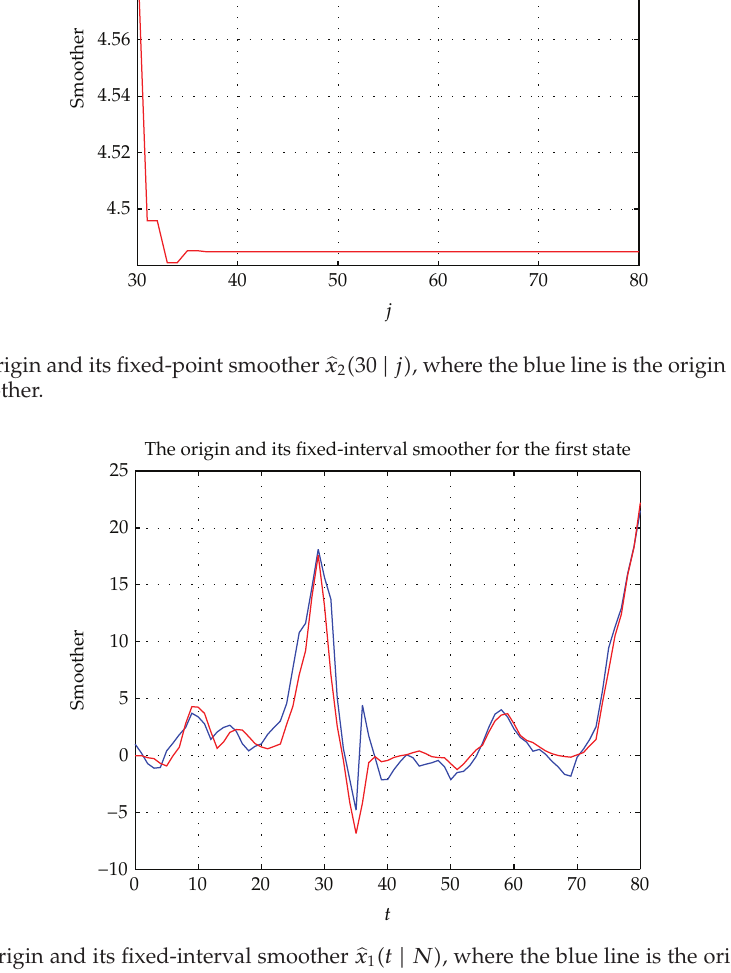
Figure 3: The origin and its fixed-interval smoother (cid:13) x 1 (cid:2) t | N (cid:3) , where the blue line is the origin signal, the red line is the